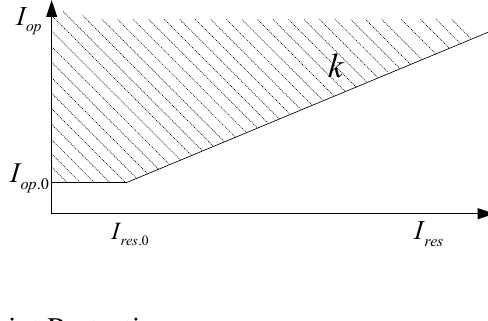
Figure 6. Operation zone of percentage differential